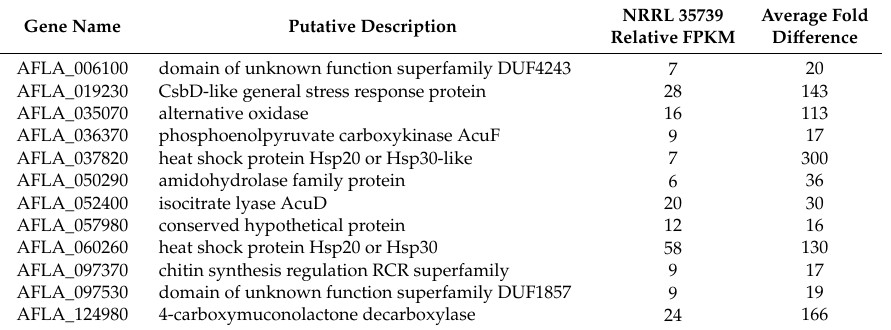
Table 5. Genes with di ff erential relative expression of interest in the A. flavus NRRL 3357